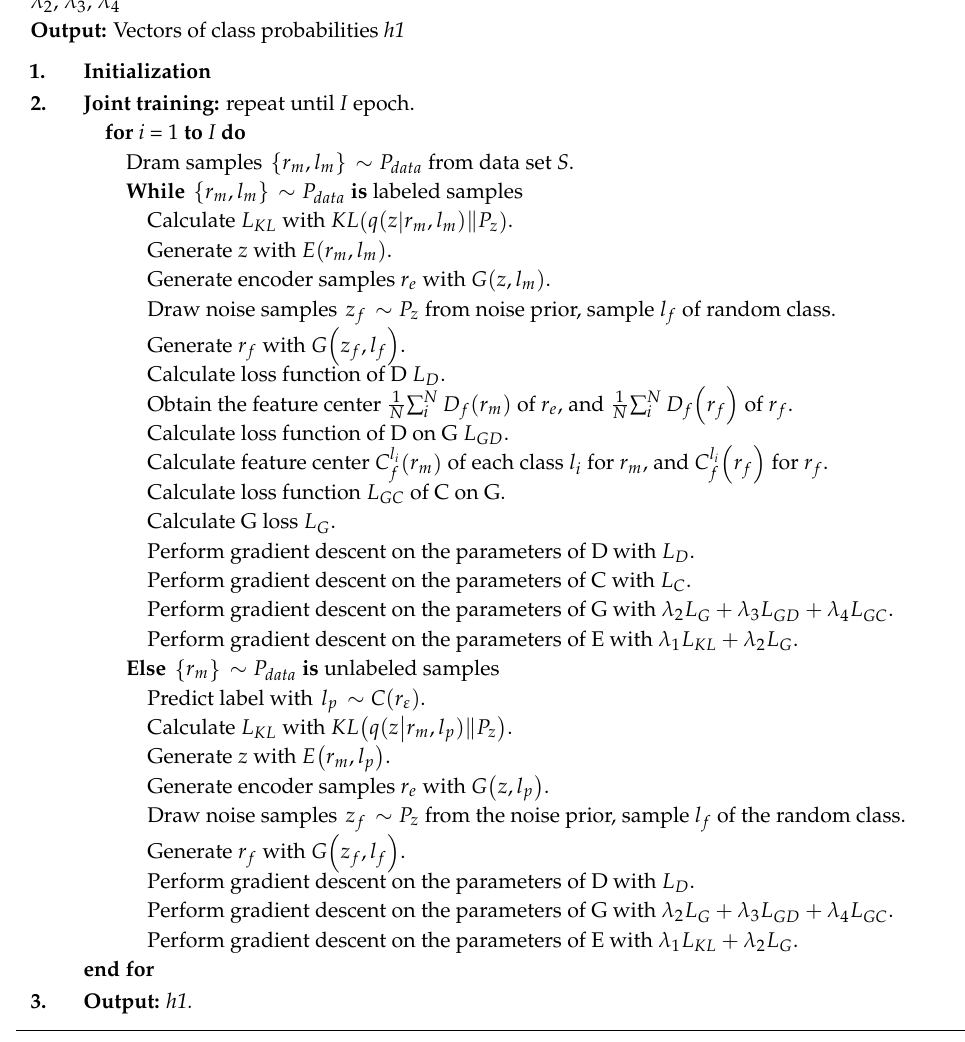
Algorithm 1. Semi-Supervised Learning through Asymmetric